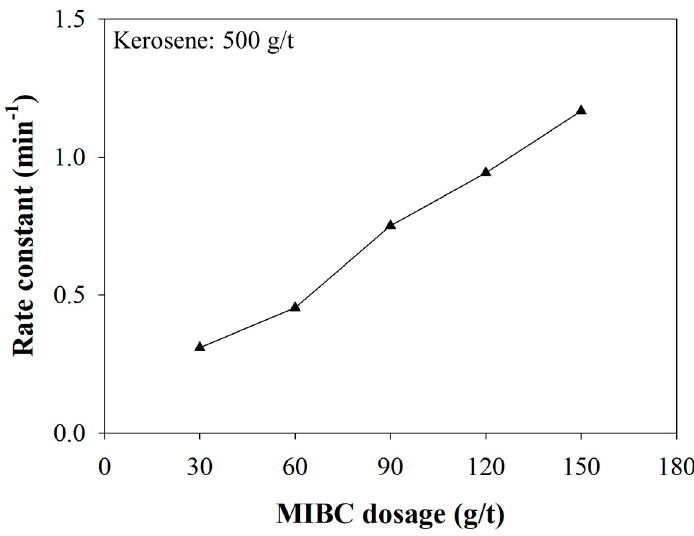
Figure 7. Flotation rate constant change against MIBC dosage: kerosene dosage, 500 g/t; agitation speed, 1200 rpm.